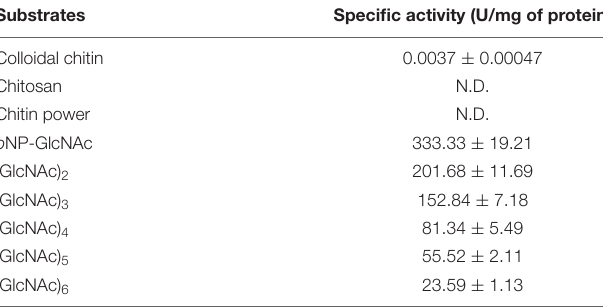
TABLE 2 | Substrate specificity of